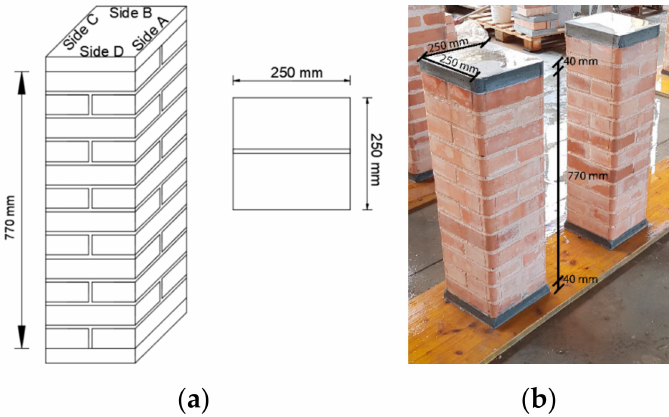
Figure 1. Geometry of the masonry columns. ( a ) Scheme of the column; ( b ) un-confined